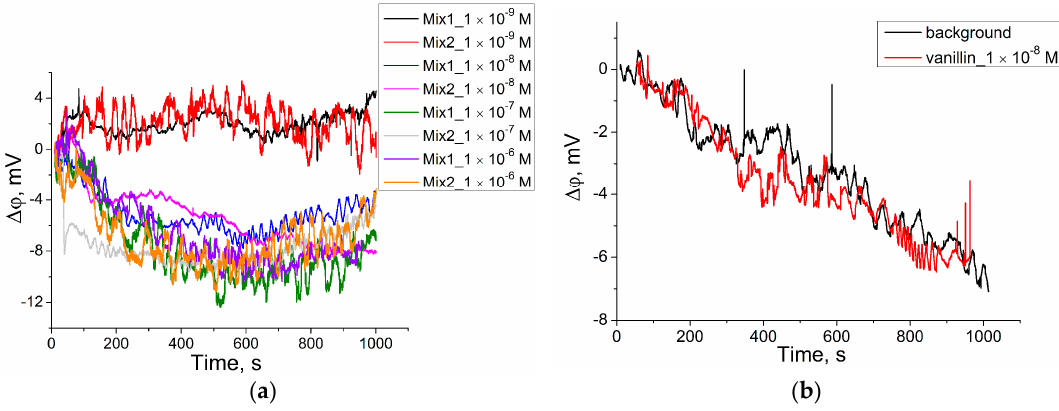
Figure 6. ( a ) Dependence of response (with background subtraction) of modified with Van_74/DP ISFETs to the Bsm DNA polymerase reaction with the addition of different vanillin